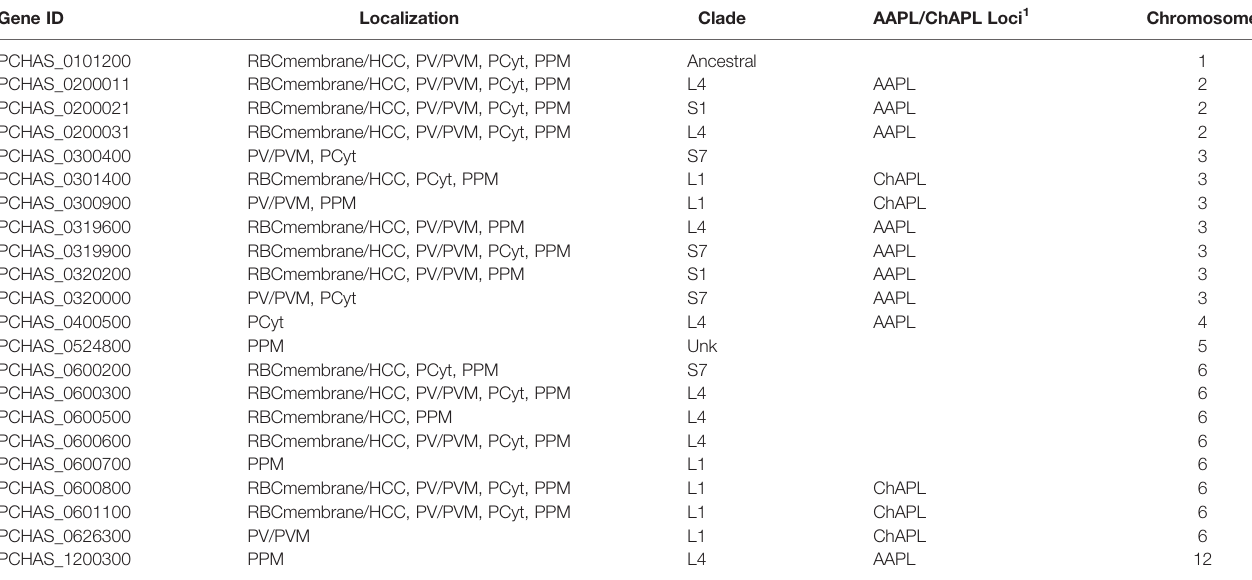
TABLE 1 | Localisation pattern of PIR proteins identi fi ed in proteome analyses of fractionated samples prepared from P. chabaudi infected erythrocytes at the acute phase of infection.